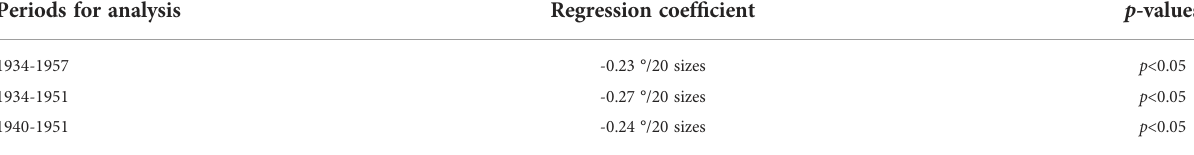
TABLE 2 The regression coef fi cient between the sample size and monthly SST difference (ERv5 minus HadI1) averaged over region where the sampling size decreased sharply (>50%) during 1940 – 1945 for different periods. Periods for analysis